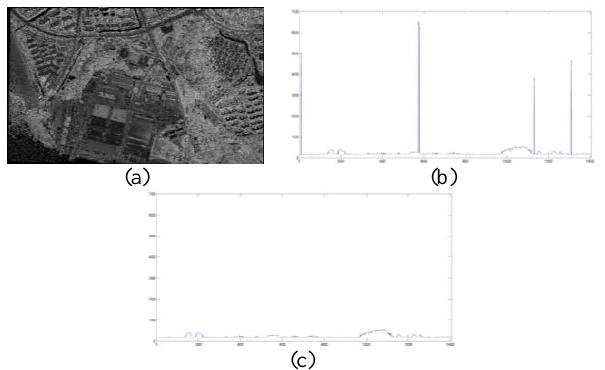
Figure 3. Denoising and result of the first dataset: (a) Gray-scale image rendered using intensity values; (b) A horizontal profile of the DSM (red crossed symbols indicate outliers); and (c) The corresponding result after denoising.